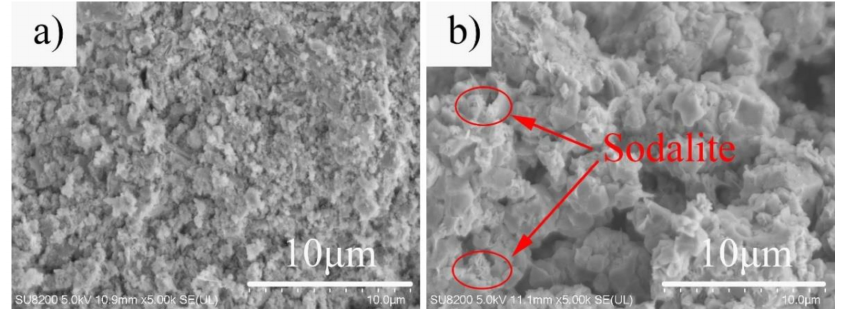
Figure 4. SEM micrographs of the samples A2-T70-H24 ( a ) and A2-T110-H24 ( b